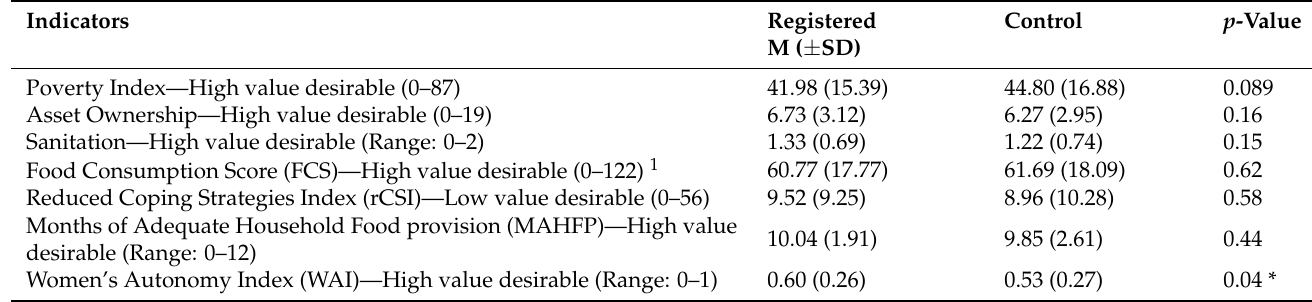
Table 4. Mean differences in poverty indicators between registered and control group